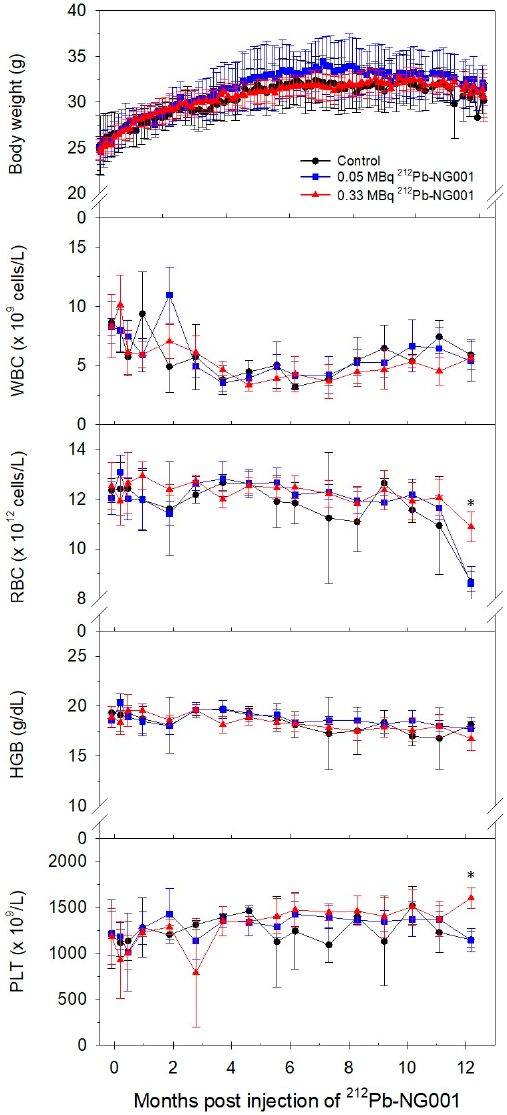
Figure 4. Changes in body weight and blood parameters, namely white blood cell (WBC), red blood cell (RBC), haemoglobin (HGB) and platelet (PLT) counts, of immunocompetent BALB/c mice after administration of saline (control, N = 3), 0.05 MBq (N = 5) or 0.33 MBq (N = 5) of 212 Pb-NG001. * p < 0.05 compared to the other